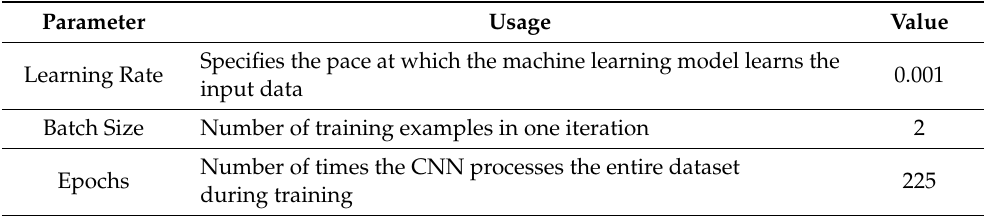
Table 3. Final optimized parameters for training each Mask R-CNN model for LEE quantification and classification.